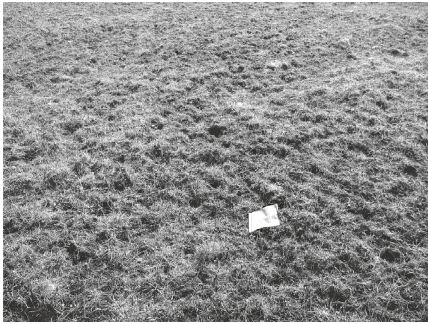
Figure 12: Cape Collingwood outlier plot, showing the heavy moss